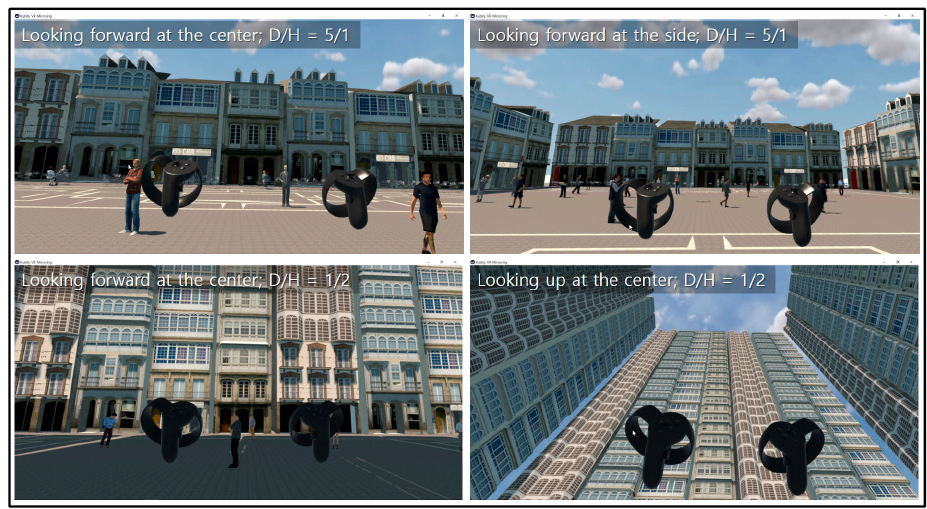
Figure 1. Sample images of simulated squares (captured images of Kubity VR mirroring).